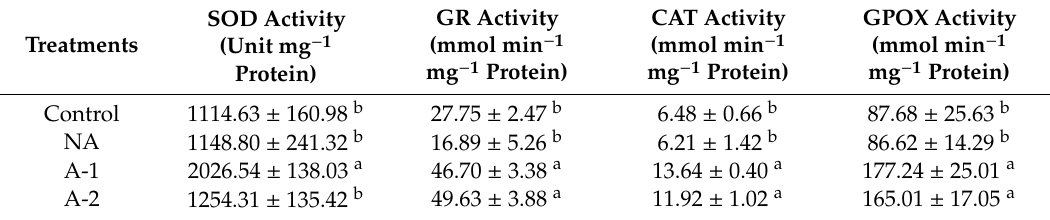
Table 2. E ff ects of 10-days sodic-alkalinity with 100 mM NaHCO 3 on superoxide dismutase (SOD), glutathione reductase (GR), catalase (CAT), and guaiacol peroxidase (GPOX) activities in the leaf tissues of pre-acclimated rye. Rye plants were pre-acclimated by 0 mM NaHCO 3 (NA) and 1 and 2 mM NaHCO 3 (A-1, A-2) for 10 days. Control plants were consistently irrigated by nutrient